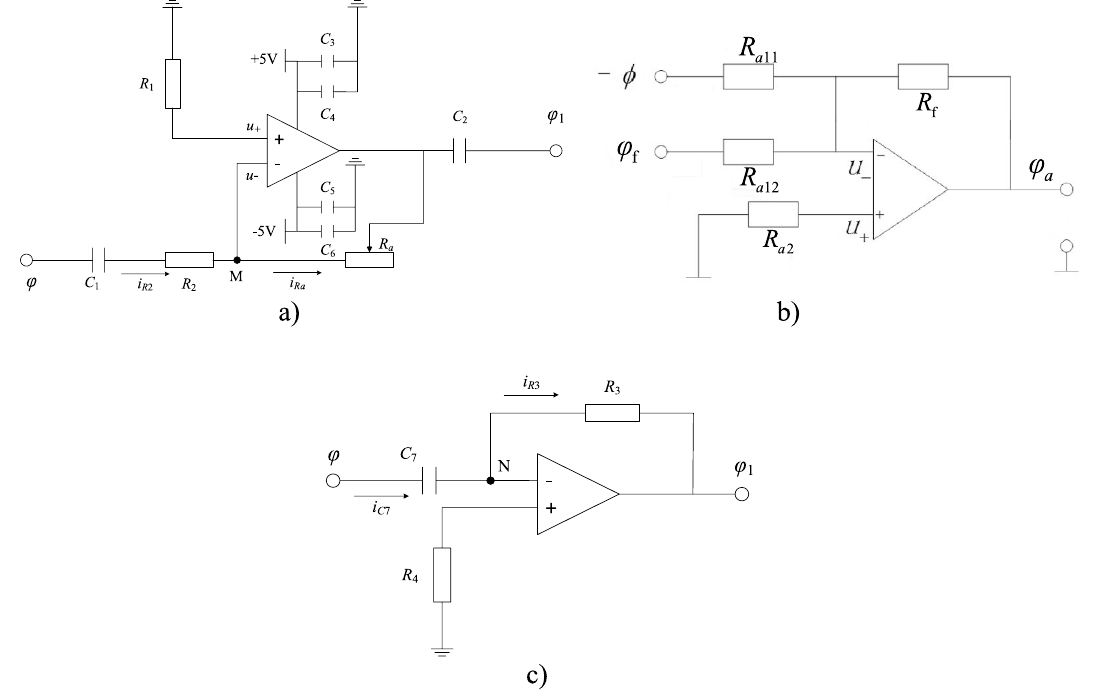
Figure 9. Feedback control elements. ( a ) Inverse proportional amplifier; ( b ) Inverse adder. ( c ) Inverse differential